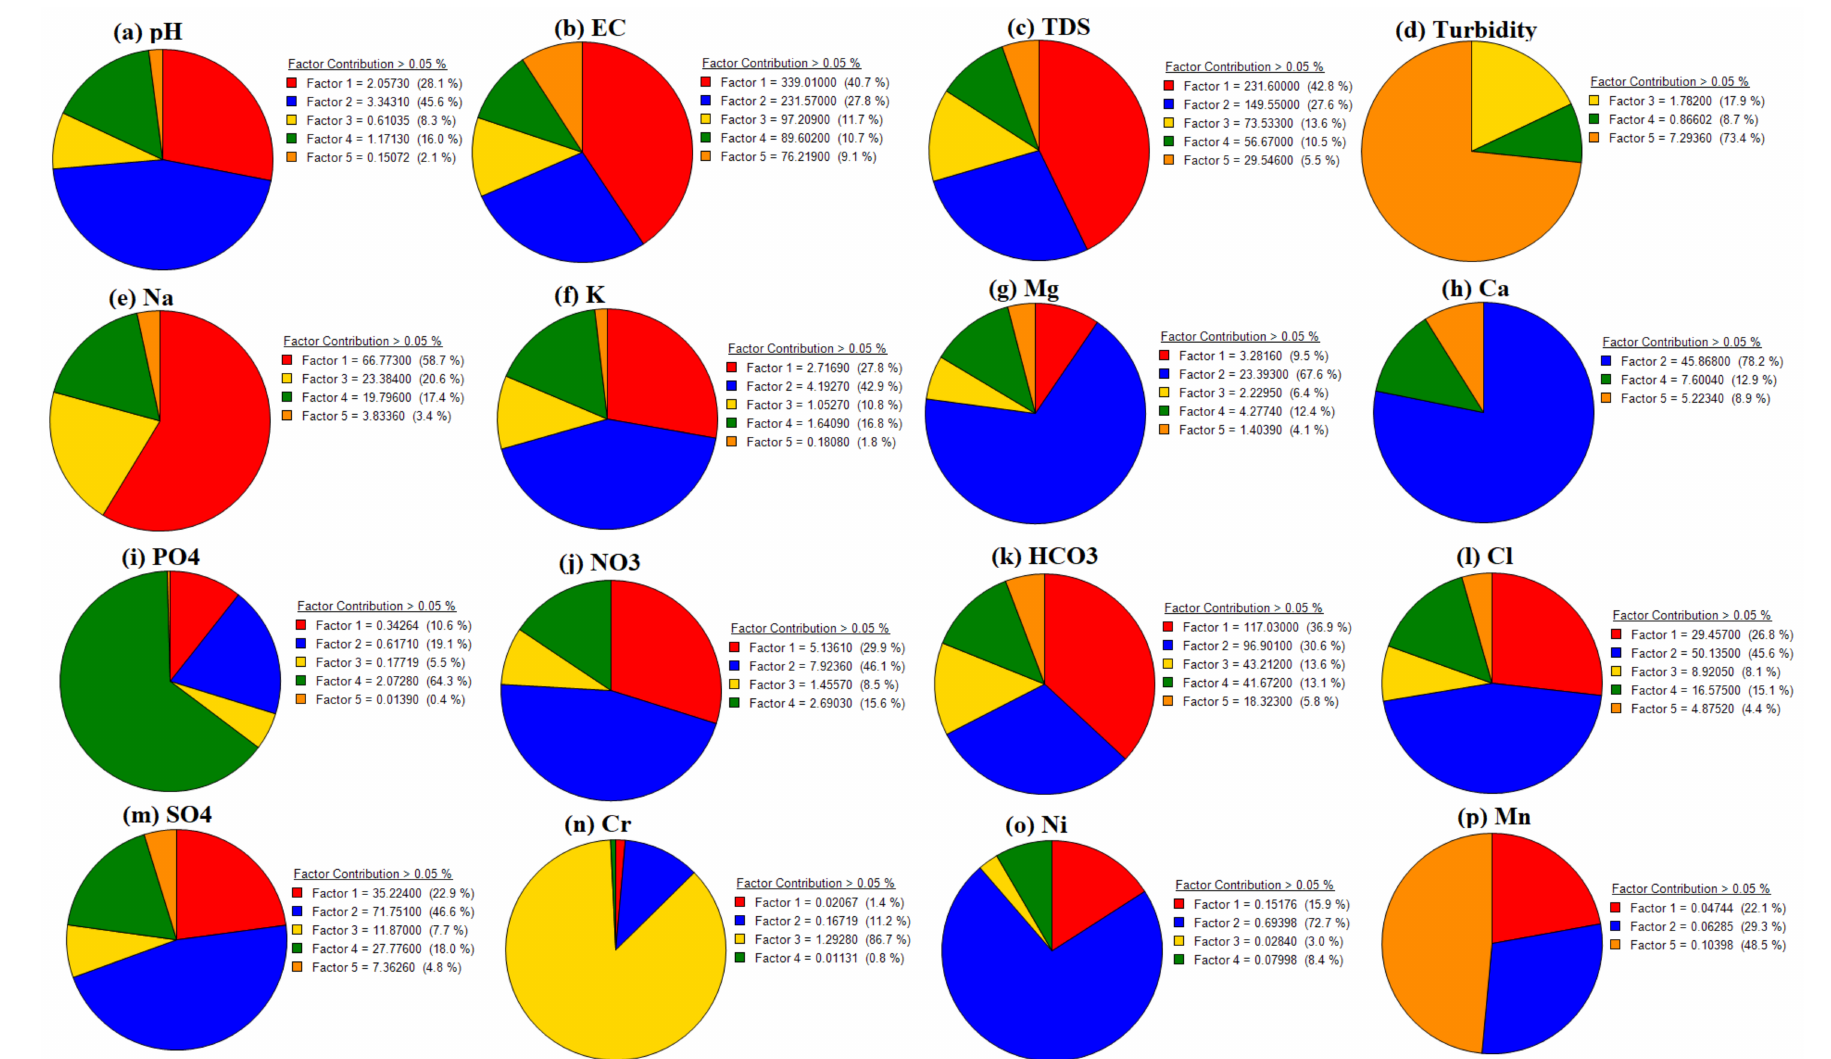
Figure 10. Shows percentage contributions and cumulative sum of individual parameters compiling factors by PMF receptor